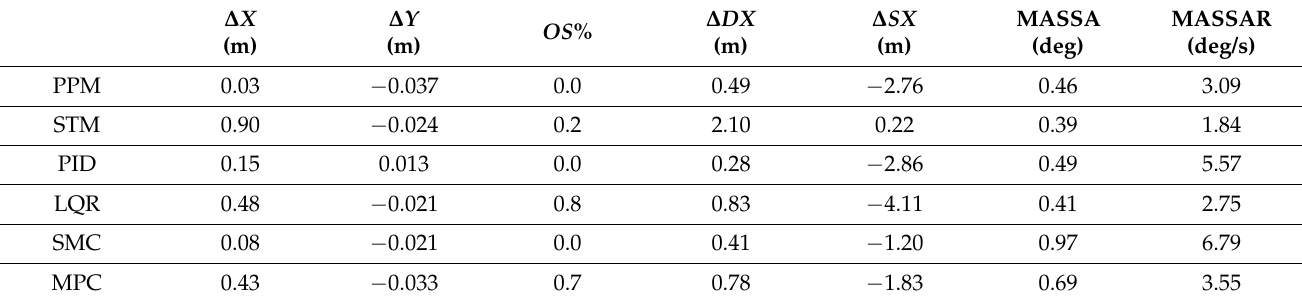
Table 3. Summary of simulation results of each controller for 4WS vehicle in the first set of simulations.